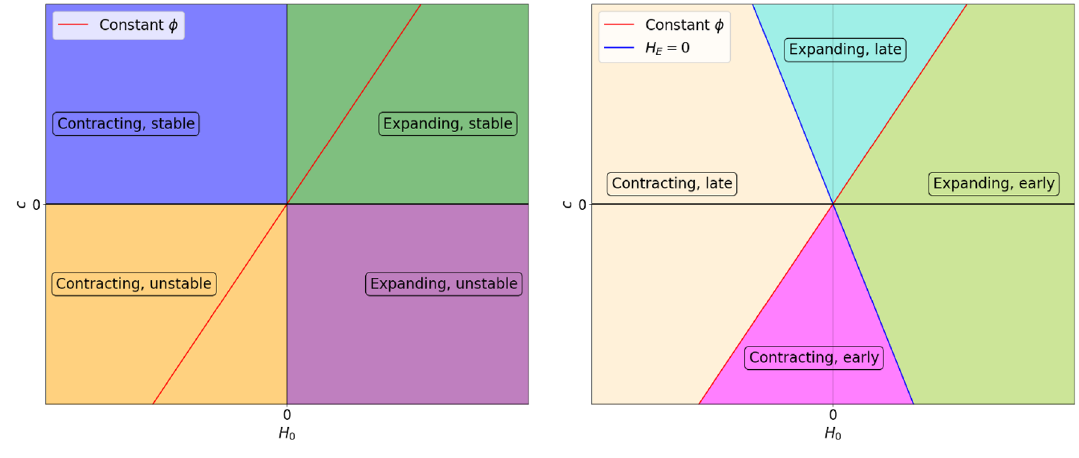
Figure 1. ( a ) expansion H 0 > 0 /contraction H 0 < 0 and stability. The red line is the region φ = constant ⇐⇒ c = nH 0 . ( b ) expansion H E ( t ) > 0 /contraction H E ( t ) < 0 . Late and early refer to the times for which g s = e φ ( t ) (cid:28) 1 . The blue line is the region H E = 0 ⇐⇒ c = − ( d − n − 1) H 0 and the red line is the region φ = constant with g s = e φ 0 (cid:28) 1